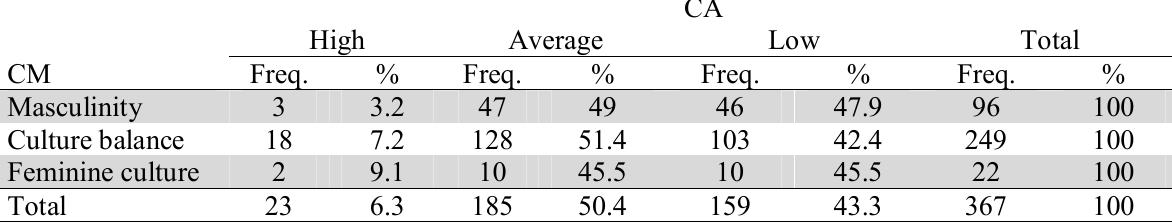
The summary of testing the first hypothesis (Relationship between CA and CM) CA High Average Low Total CM Freq. % Freq. % Freq. % Freq. % Masculinity 3 3.2 47 49 46 47.9 96 100 Culture balance 18 7.2 128 Feminine culture 2 9.1 10 45.5 10 45.5 100 Total 23 6.3 185 50.4 159 43.3 367